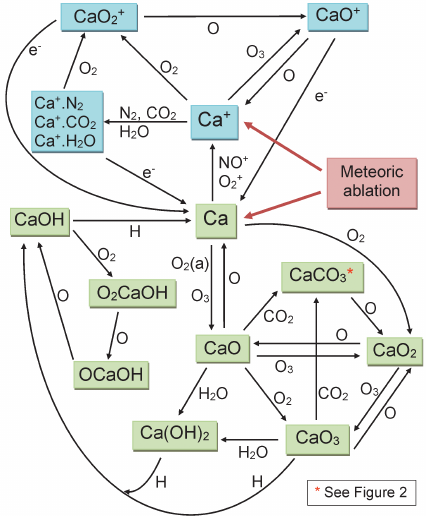
Figure 1. Schematic diagram of the Ca chemistry in WACCM-Ca. Ionized and neutral Ca-containing species are shown in blue and green boxes,